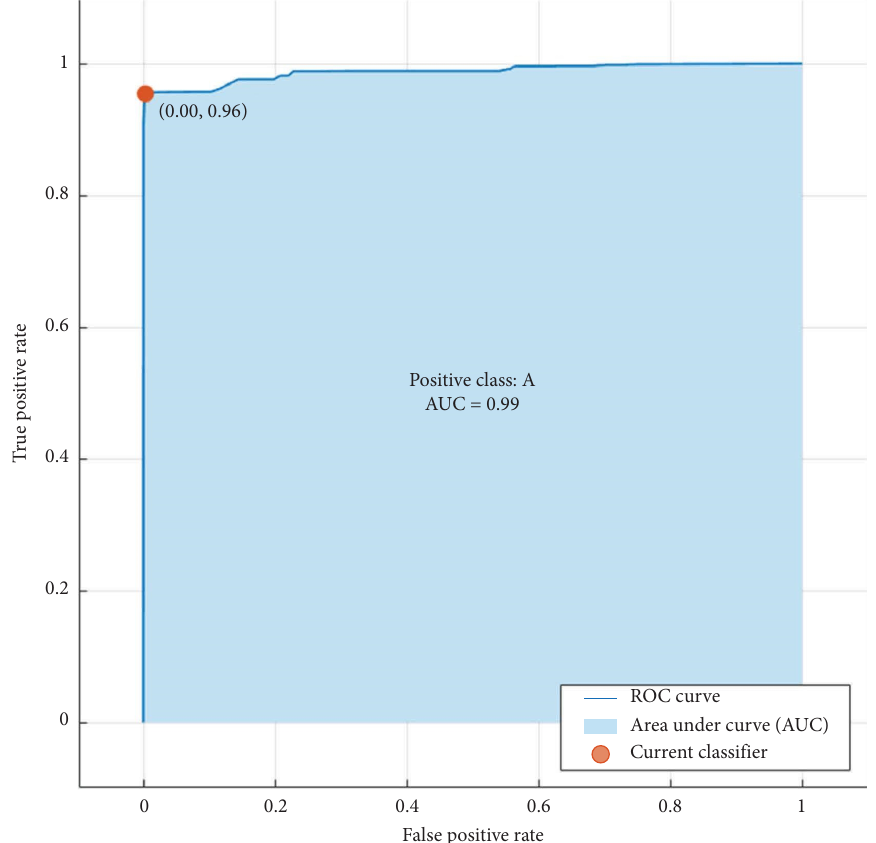
Figure 12: ROC curve for class